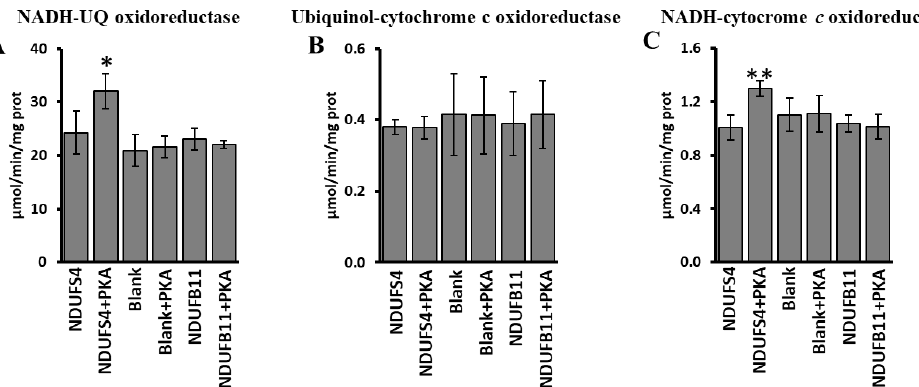
Figure 7. PKA addition to mitochondrial import experiments increased the activity of complex I and complex I/III. RRL translation mixtures containing newly synthesized [ 35 S]-Met labeled NDUFS4 protein or [ 35 S]-Met-labeled NDUB11 protein or no protein present (Blank) were added to the import mixture containing RLM in absence and in the presence of PKA. After 60 min incubation at 30 °C, mitochondria were spun down from the import mixture and used for spectrophotometric analysis. ( A ) Activity of complex I (NADH-UQ oxidoreductase). ( B ) Activity of complex III (ubiquinol-cytochrome c oxidoreductase). ( C ) Activity of complex I/III (NADH-cytochrome c oxidoreductase). The values are the means ± SD of three different experiments. (NDUFS4 + PKA vs. NDUFS4, * p < 0.05, ** p < 0.01, Student’s t -test). For more details, see under Materials and Methods.